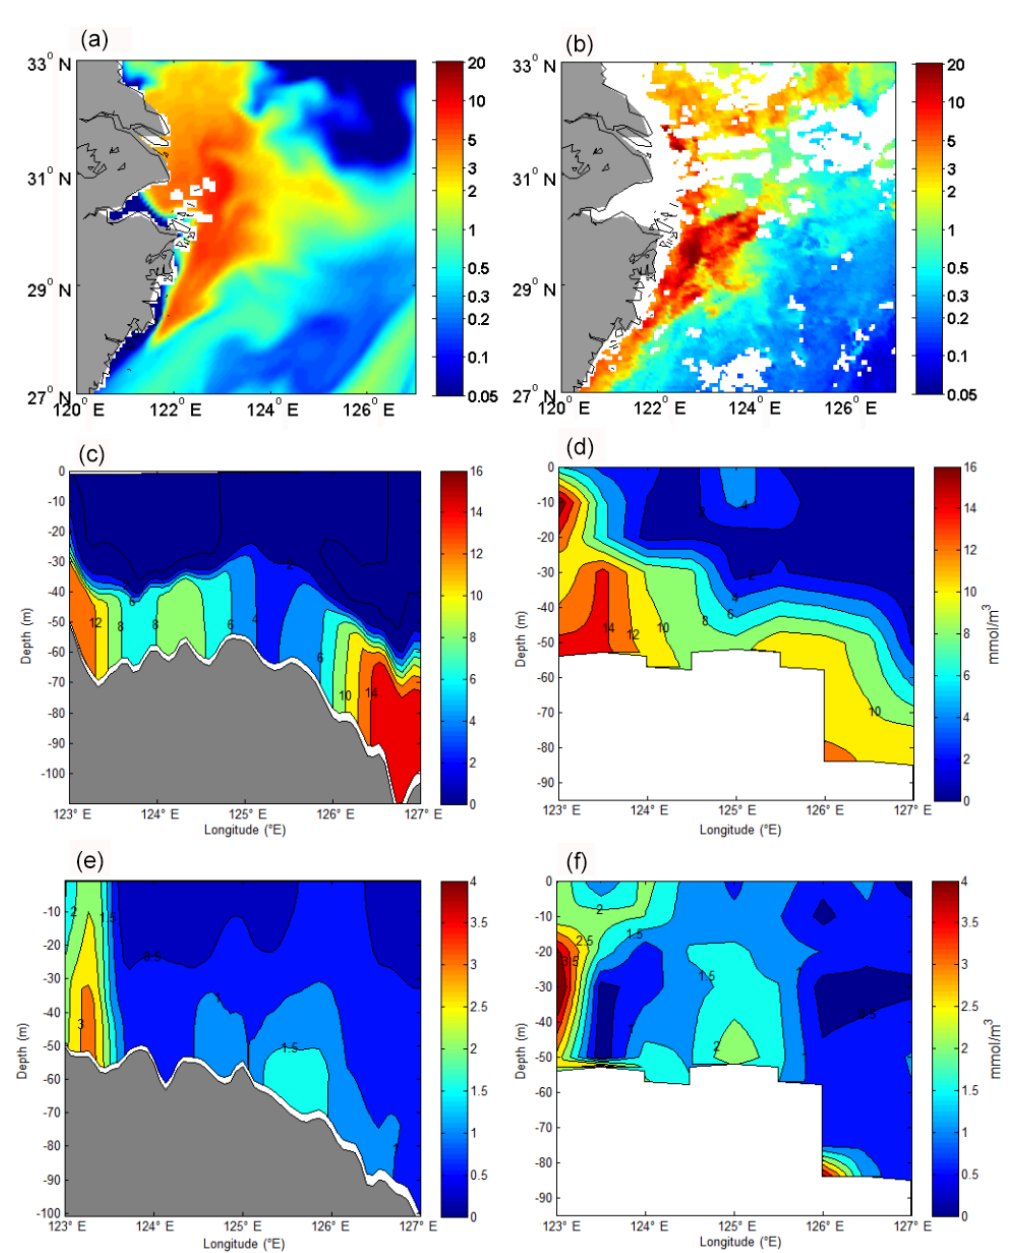
Figure 5. The comparison between modeled results (a) and MODIS-derived data (b) of chlorophyll a concentration in August 2011. The comparison between modeled results (c) and in situ data (d) of NO 3 along the section at 30 ◦ N in August 2011. The comparison between modeled results (e) and in situ data (f) of NH 4 along the section at 30 ◦ N in August